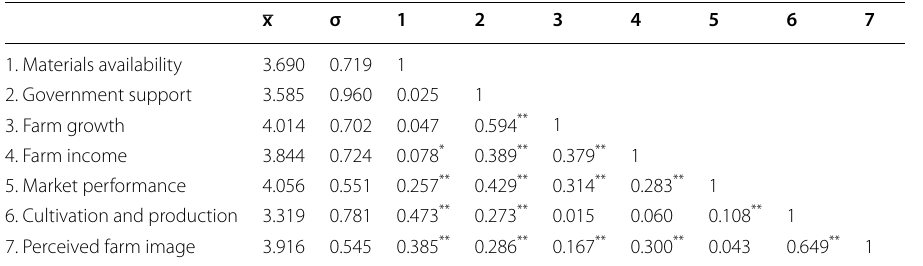
Note: ** denotes 1% and * denotes 5% levels of